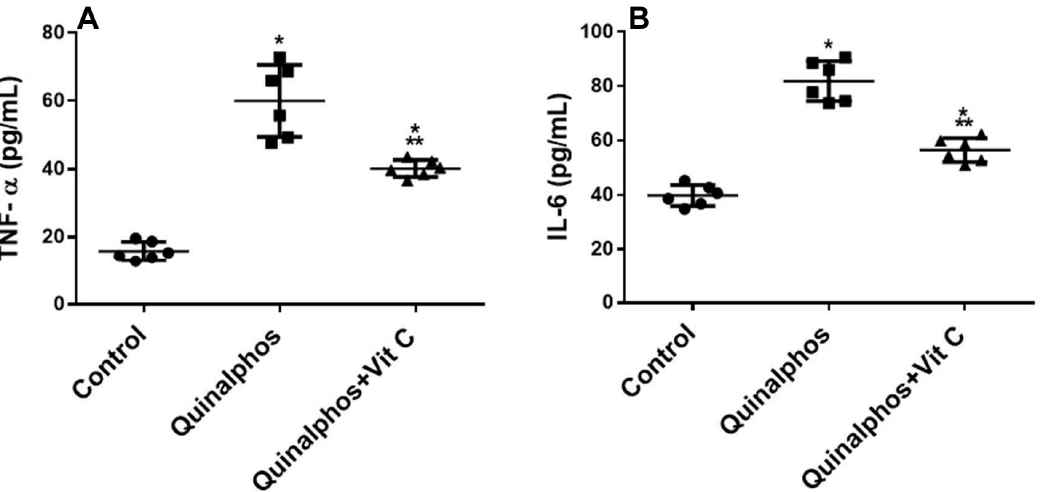
Figure 2. In rats, Vit C suppresses QP-induced inflammatory indicators. The levels of TNF- α ( A ) and IL-6 ( B ) in the blood of three groups of rats were measured at the end of the experiment: control, QP, and QP + Vit C. The findings are the mean (SD) for each group; n = 6. Experiments were carried out in triplicate. * p < 0.05 in comparison to control, ** p < 0.05 in comparison to QP group. As indicated in Figure 2A,B, QP enhanced heart tissue injury considerably ( p < 0.05). Vit C decreases both inflammatory biomarkers in comparison to the QP